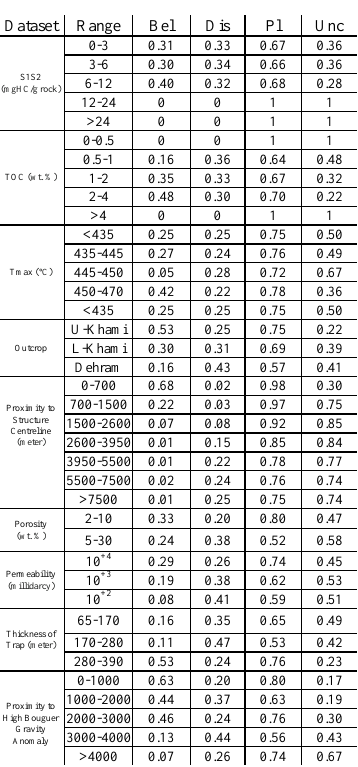
Table1.EBF’s functions quantities assigned for petroleum